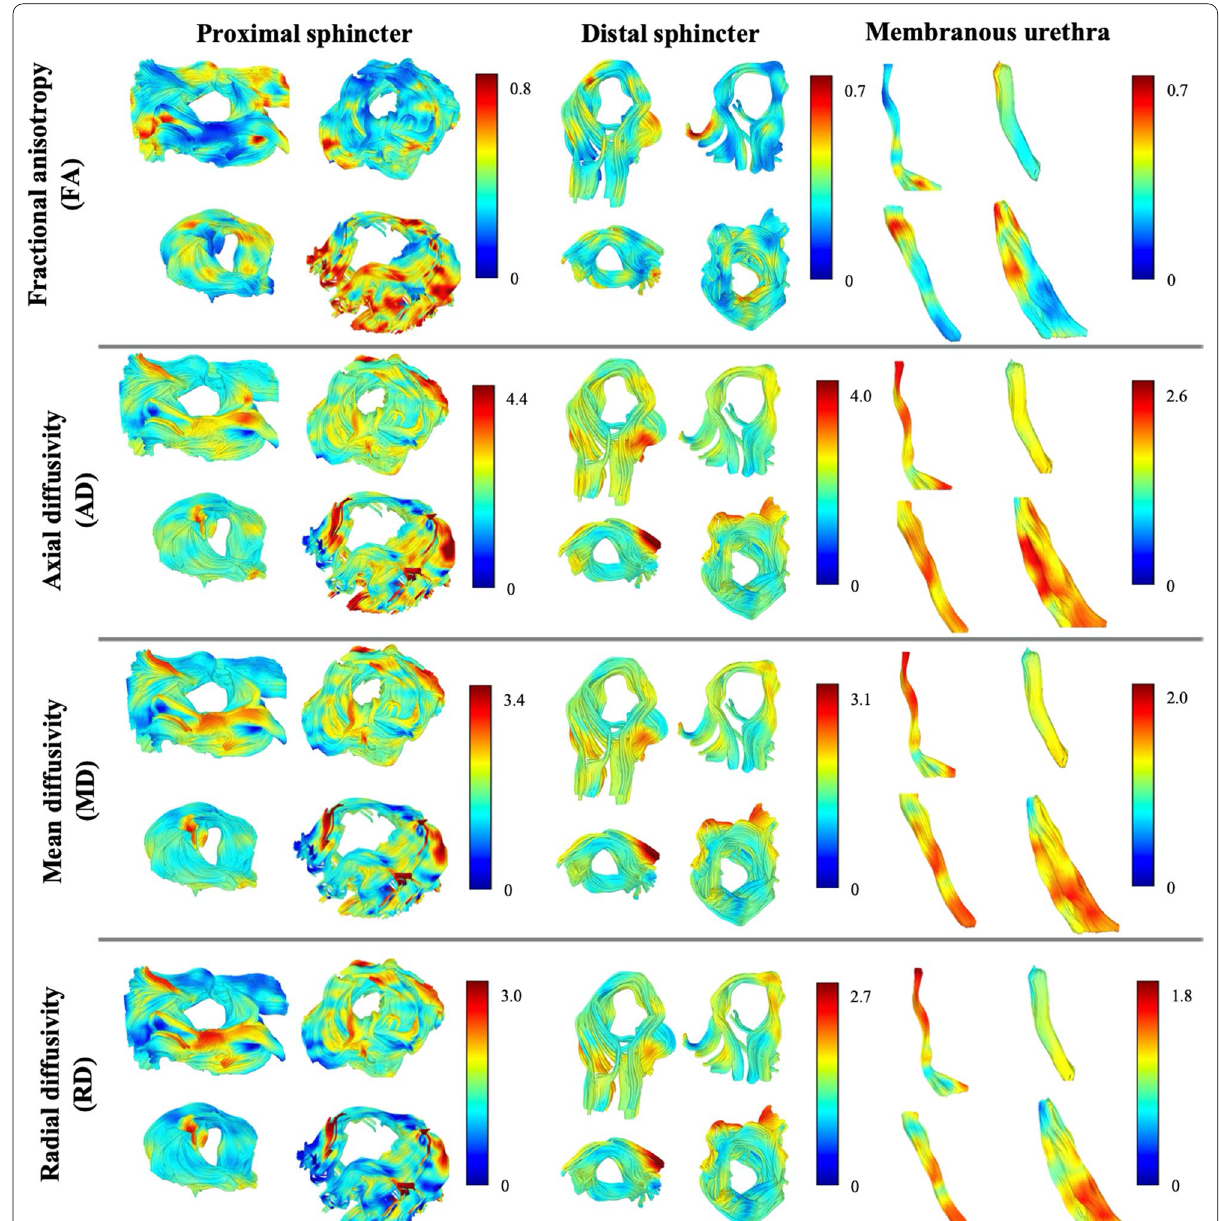
Fig. 7 Four arbitrarily chosen representative patients’ proximal, distal sphincters and membranous urethra, color-coded using the maximum intensity of each DTI metric (from top to bottom, FA, AD, MD, and RD). Red depicts regions with a higher DTI metric value (set to the maximum value of that metric among all patients), while blue depicts regions with a DTI metric value closer to